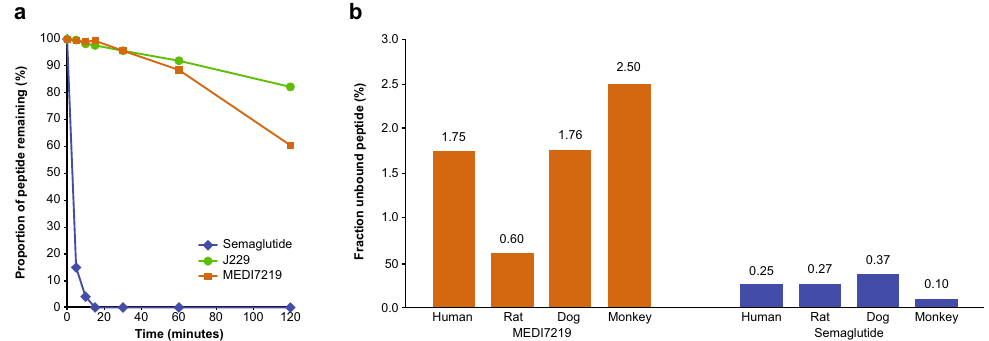
Figure 2. In vitro evaluation of GLP-1RAs. ( a ) FaSSIF incubation assay showing proportion of J229, MEDI7219 or semaglutide remaining after 2 h incubation with FaSSIF/pancreatin. ( b ) EScalate Equilibrium Shift Assay of protein binding showing binding propensity of MEDI7219 and semaglutide to human, dog, monkey and rat plasma protein.